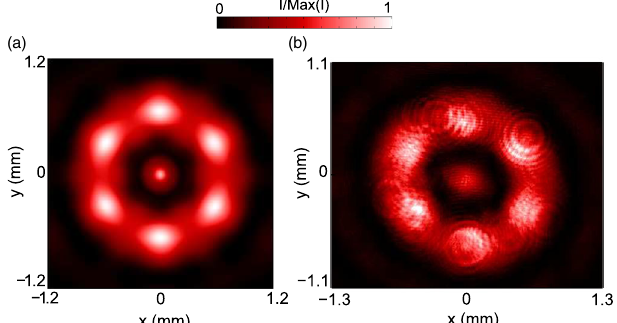
FIG. 10. (a) Simulated laser profile output for setting the MMDM actuator voltages to alternating zero and maximum on each radial hexagonal ring group, using a Gaussian input laser.